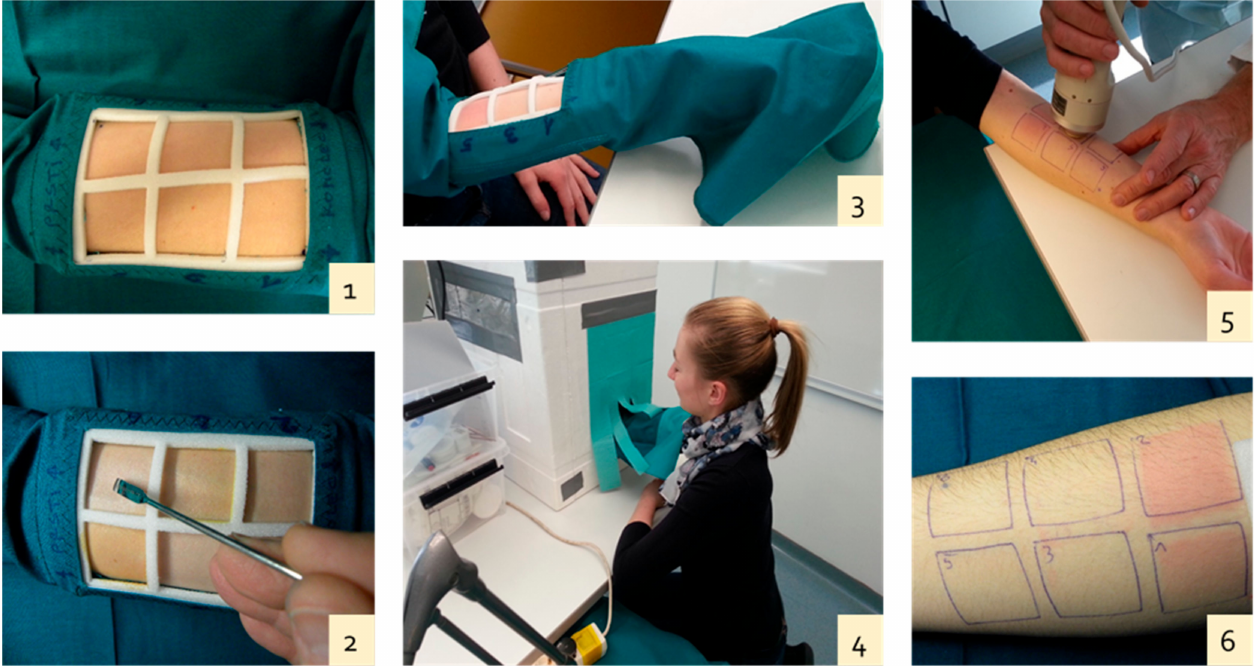
Figure 1. The irradiation field with a custom-made glove with six cut squares ( 1 ), the application of individual ointment ( 2 ), the position of six squares 3 × 3 cm (9 cm 2 ) on the adult forearm, ( 3 ) the glove use, ( 4 ) the tailor made irradiation chamber, ( 5 ) the skin color measurement, ( 6 ) the differences in skin